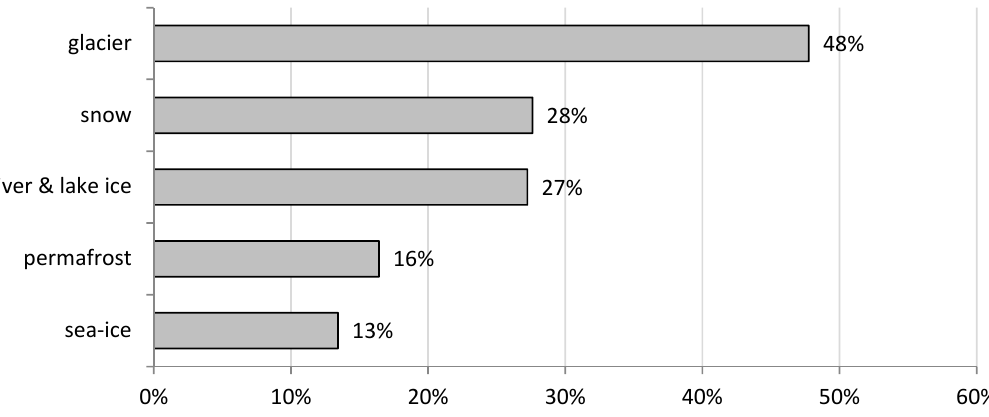
Figure 6. Thematic fields of cryosphere-related TerraSAR-X proposals, sorted by frequency, addressing polar and mountain glaciers, snow, permafrost, sea-, lake- and river-ice.